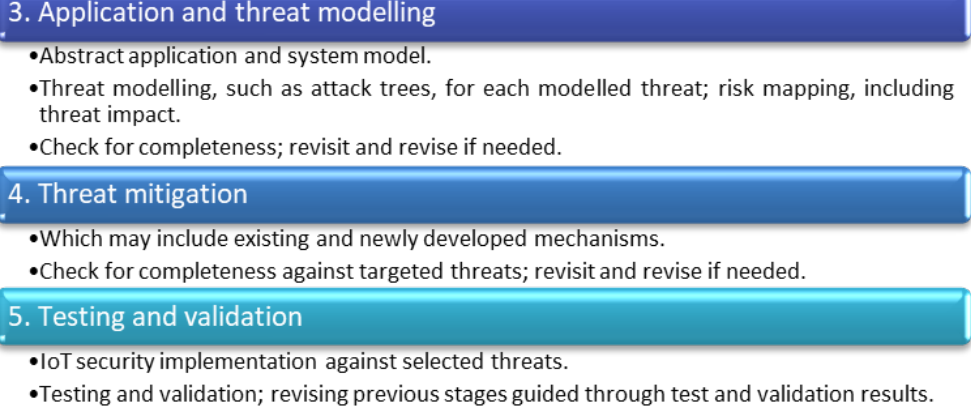
Figure 2. Design thinking approach for Internet of Things (IoT) device security.